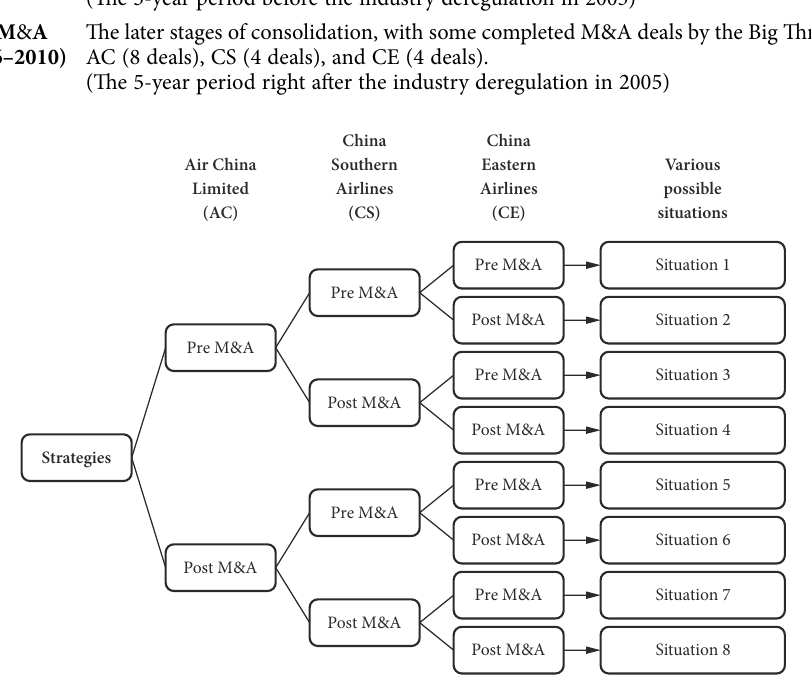
Figure 3. Eight scenarios for Cournot model